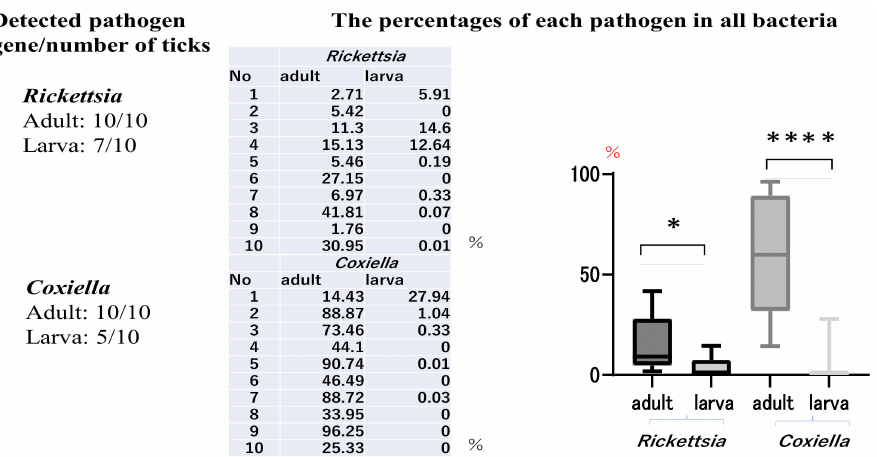
Figure 1. The gene detection rates in the adult ticks were 10/10 for Rickettsia sp. and 10/10 for Coxiella sp. Conversely, the detection rates for larval ticks were 7/10 for Rickettsia sp. and 5/10 for Coxiella sp. * When the percentage of Rickettsia sp., out of all pathogens detected via next-generation sequencing, was analyzed between the adult and larval stages of the ticks, a significant difference was observed at p = 0.0254. **** For Coxiella sp., a highly significant difference ( p < 0.0001) was found between the adult and larval stages of the